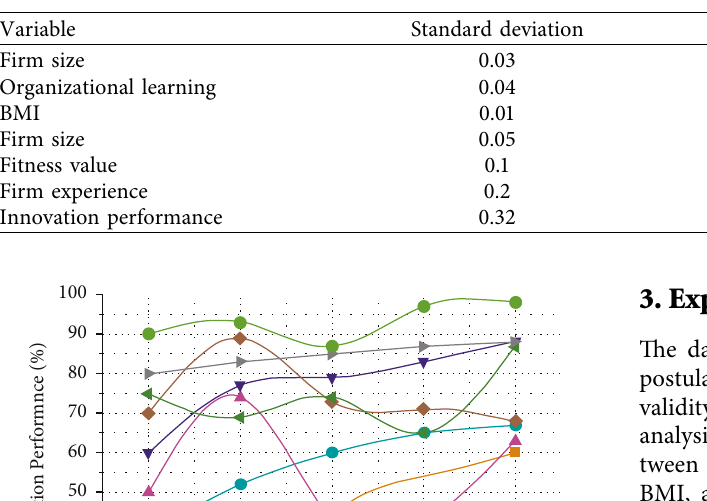
Figure 3: BMI structure to enhance a firm’s Table 1: Descriptive statistics.